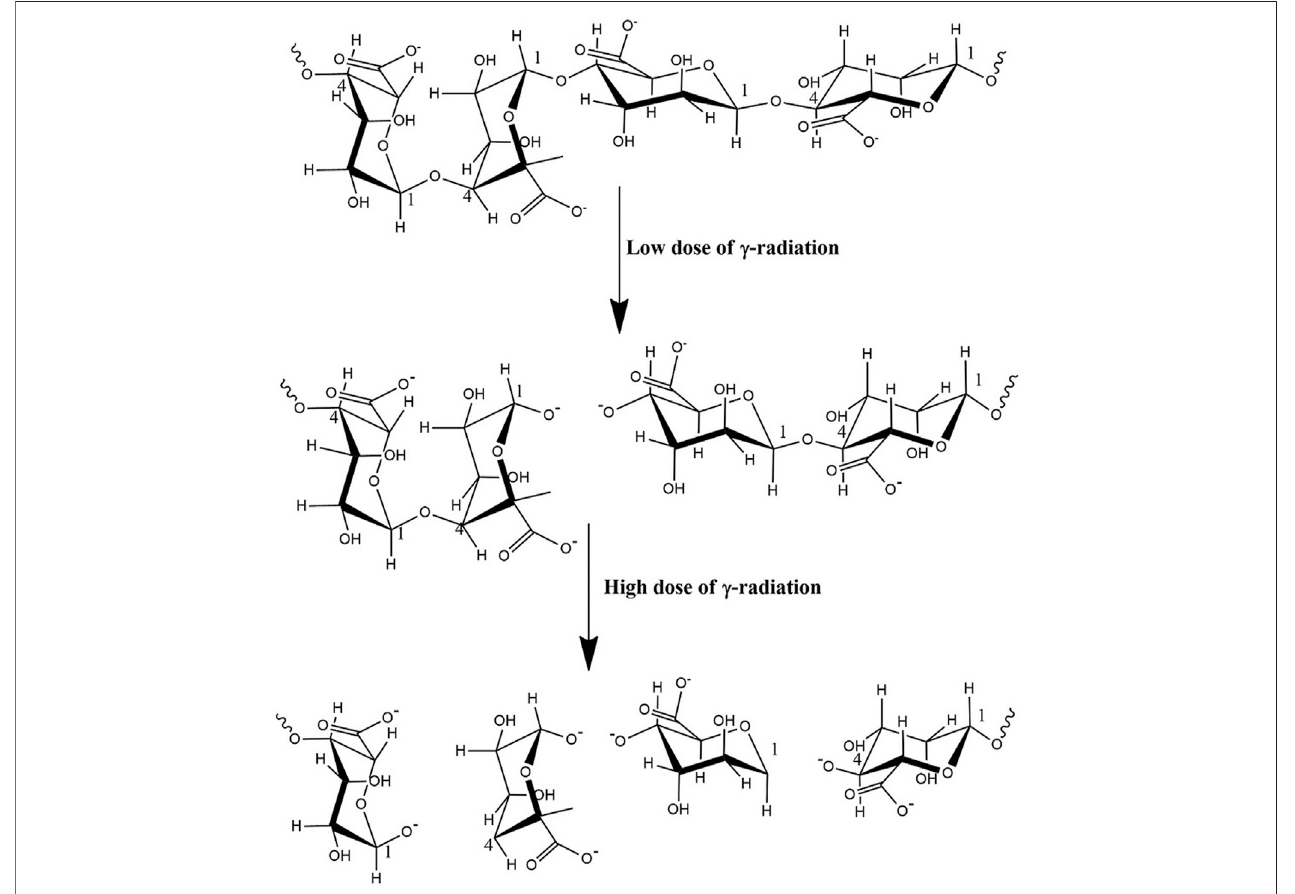
FIGURE 2 | Subunits of alginate after irradiation with low and high doses of γ -radiation.